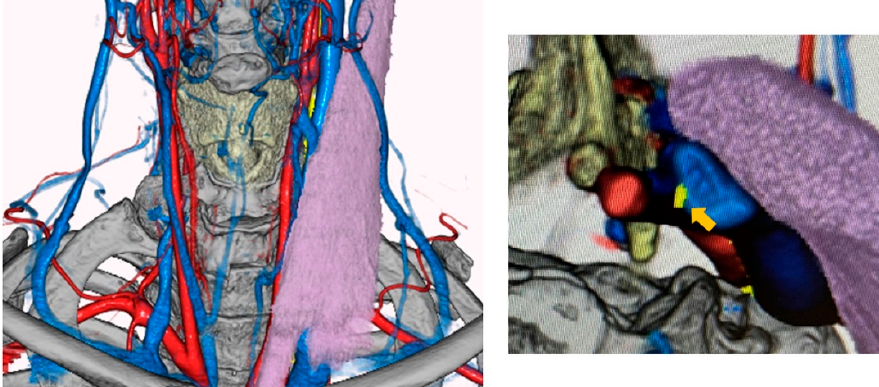
Figure 1. The visualized vagus nerve and its anatomical relationship with CCA and IJV in case 1. The vagus nerve was colored yellow in this figure (arrow). The sternocleidomastoid muscle, CCA, and IJV were colored purple, red, and blue,